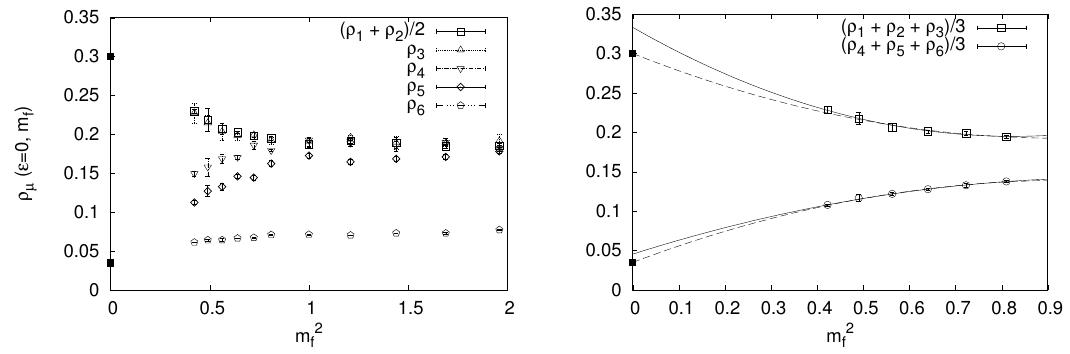
Figure 5 . (Left) The " ! 0 extrapolated values of the ratios (cid:26) (cid:22) ( "; m f ) de(cid:12)ned by (4.1) are plotted against m f2 . The (cid:12)lled squares at m f = 0 represent the GEM prediction (4.2) for ( (cid:26) 1 ; (cid:26) 2 ; (cid:26) 3 ) and ( (cid:26) 4 ; (cid:26) 5 ; (cid:26) 6 ), respectively. (Right) The averages ( (cid:26) 1 + (cid:26) 1 + (cid:26) 3 ) = 3 and ( (cid:26) 4 + (cid:26) 5 + (cid:26) 6 ) = 3 of the ratios are plotted against m f2 . The solid lines represent (cid:12)ts to a + bm f2 + cm f4 , whereas the dashed lines represent (cid:12)ts to the same form constrained to pass through the points at m f = 0 predicted from the